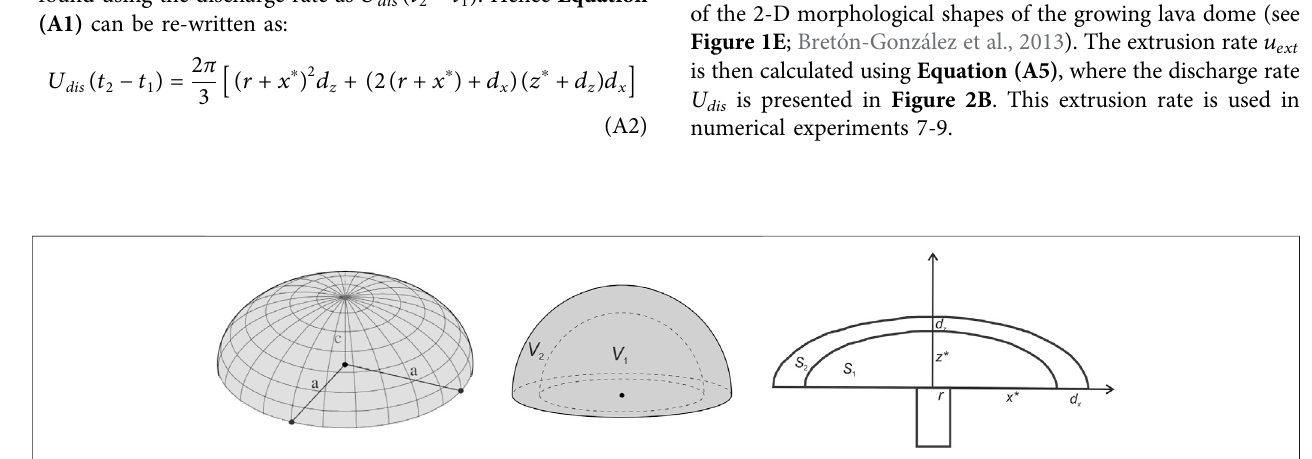
FIGURE A2 | Geometry of the half-spheroid (left and central panels) and the 2-D cross-section of the half-spheroid (right panel).